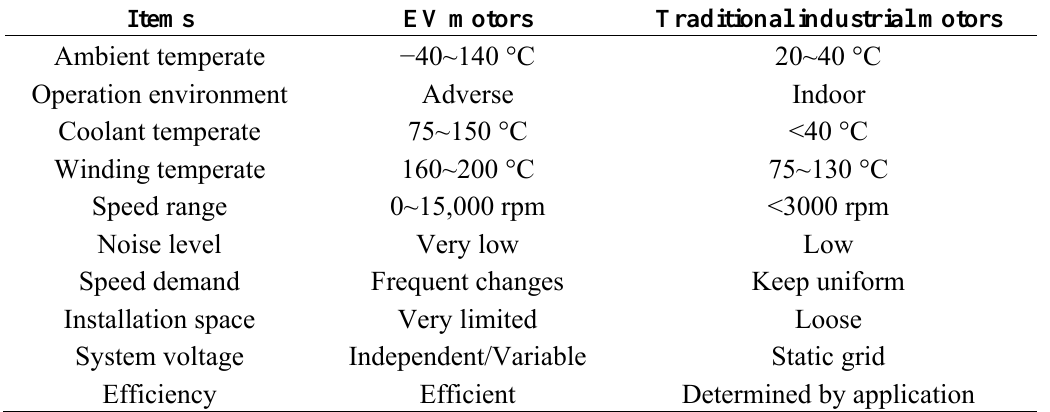
Table 1. Comparison of EV motors and traditional industrial